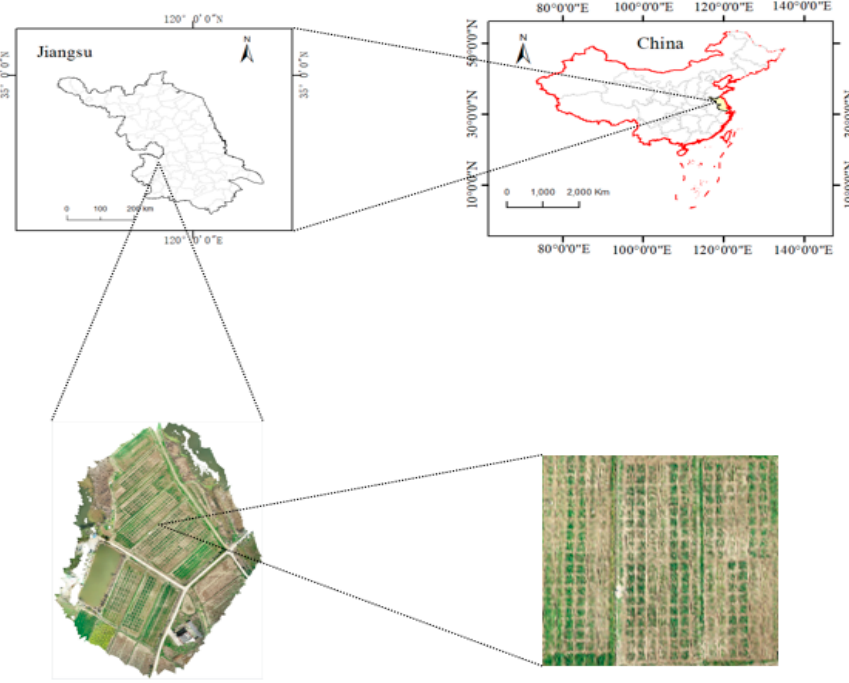
Figure 1. Experimental site in Yizheng City, Jiangsu Province, China.